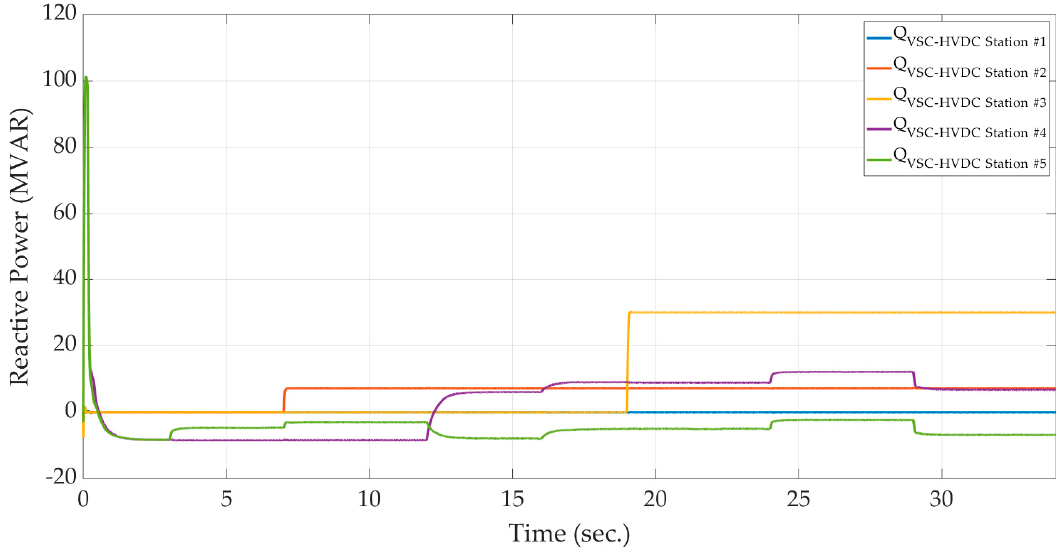
Figure 16. The reactive power profile of different VSC-HVDC stations in the second